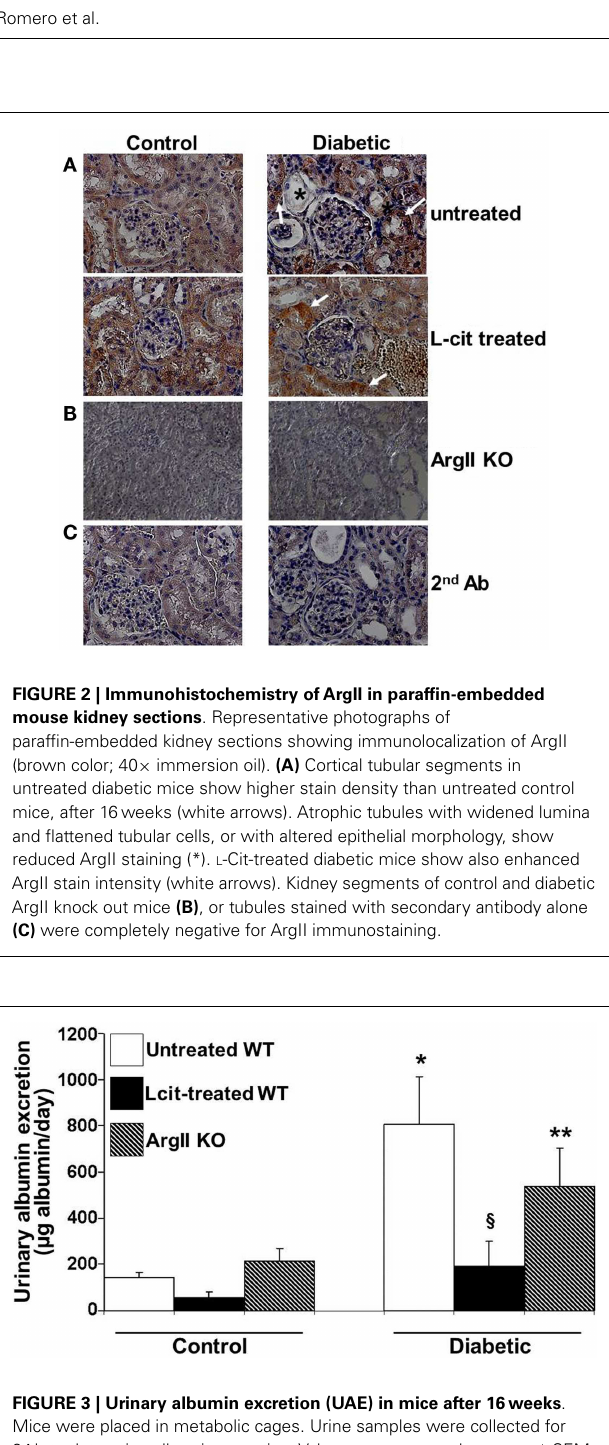
ArgII knock out mice ( Figures 4A,C ). However, no thickening of tubular basement membrane was observed in this group.